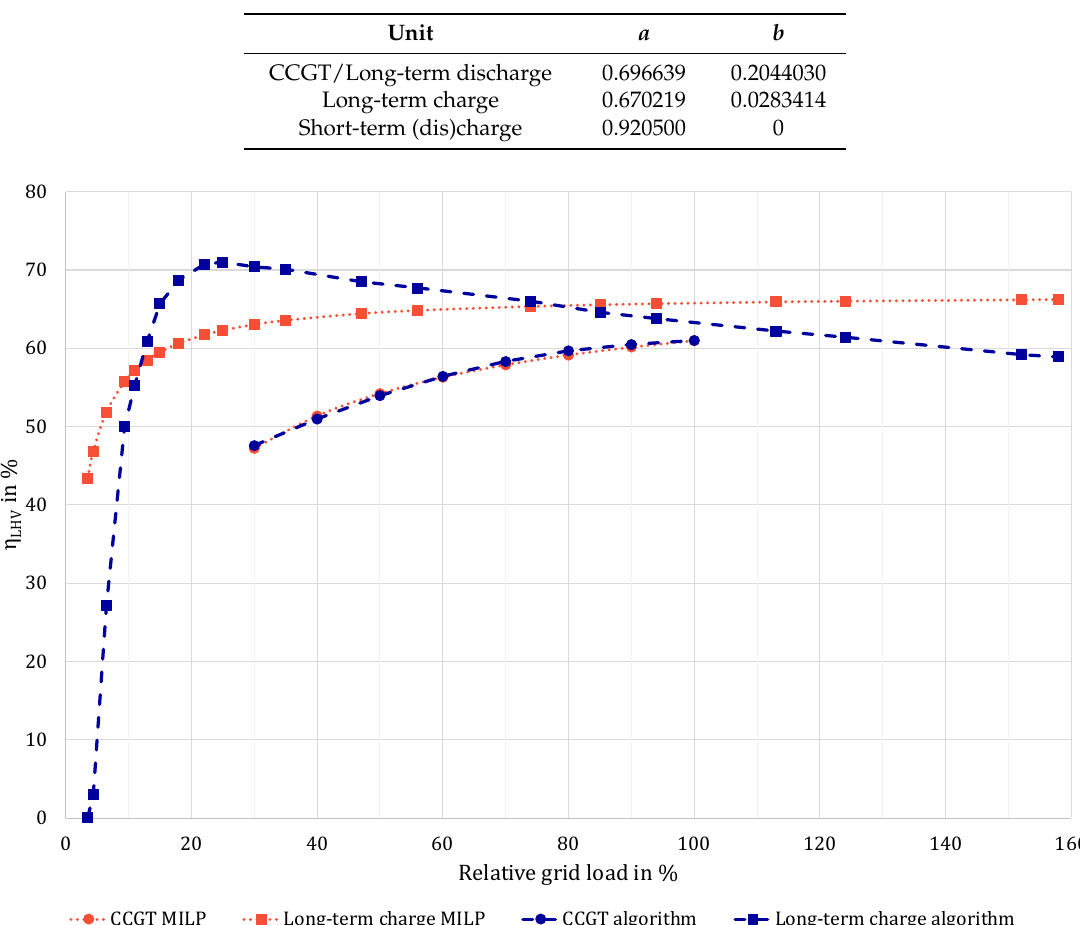
Figure 5. Efficiency curves as used in algorithm (dashed lines) and their linearised counter parts (dotted lines) as used for MILP for CCGT (which is also long-term storage discharge) (circles), and long-term storage charge unit (squares). The linearised counterparts are generated using Equation (15) with the parameters of Table 3.